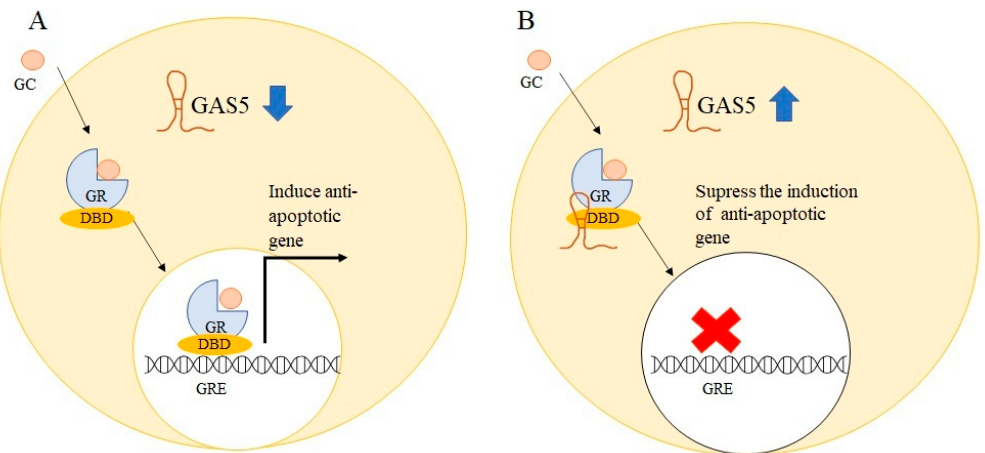
Figure 5. Schematic representation of glucocorticoid receptor (GR) activation by glucocorticoid (GC). ( A ) The glucocorticoid-activated GR bind to the glucocorticoid responsive element (GRE) via the DNA binding domain (DBD) in downregulated GAS5 solid cancer cells to induce anti-apoptotic genes such as cIAP2 , resulting in cell survival. ( B ) GAS5 acts as a GRE decoy in GAS5 elevated cells, repressing GR-mediated activation of anti-apoptotic genes and therefore sensitising cells to apopto- sis.